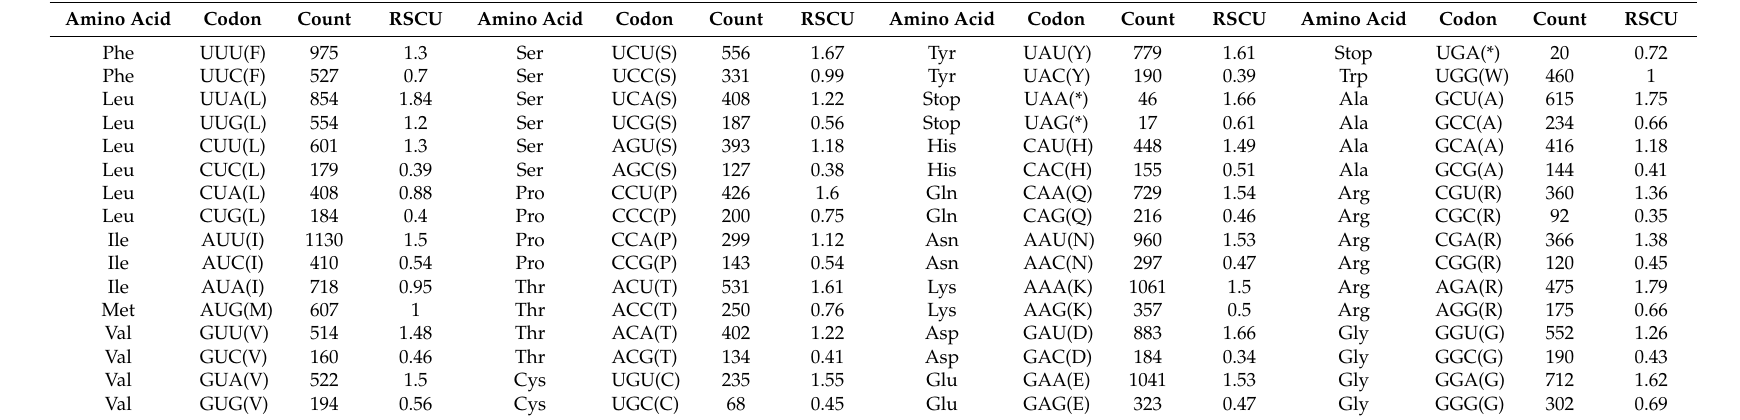
Table 4. Codon usage in the T. paniculatum cp